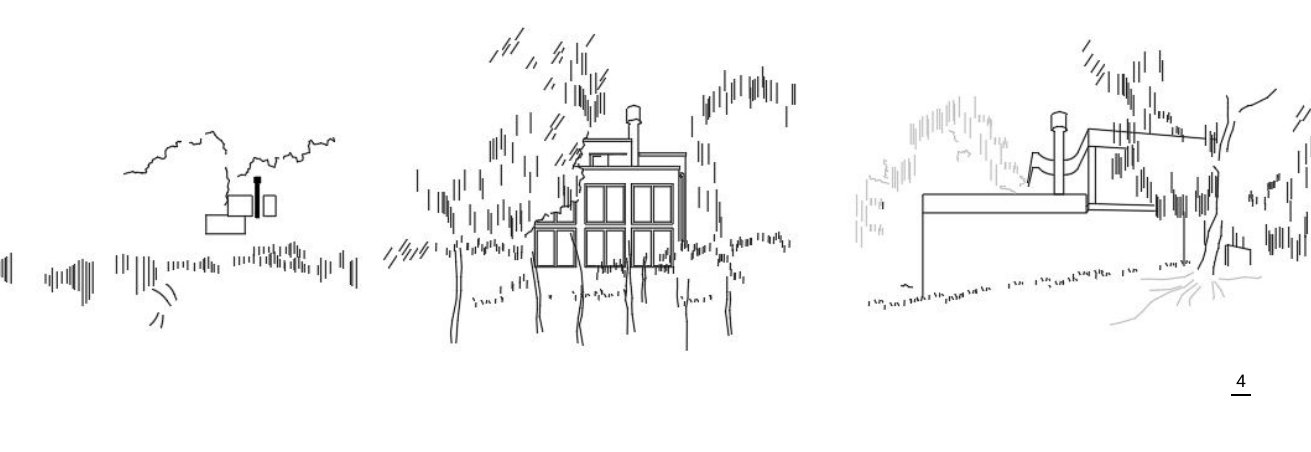
yards. The second sketch rep- resents the introspection into